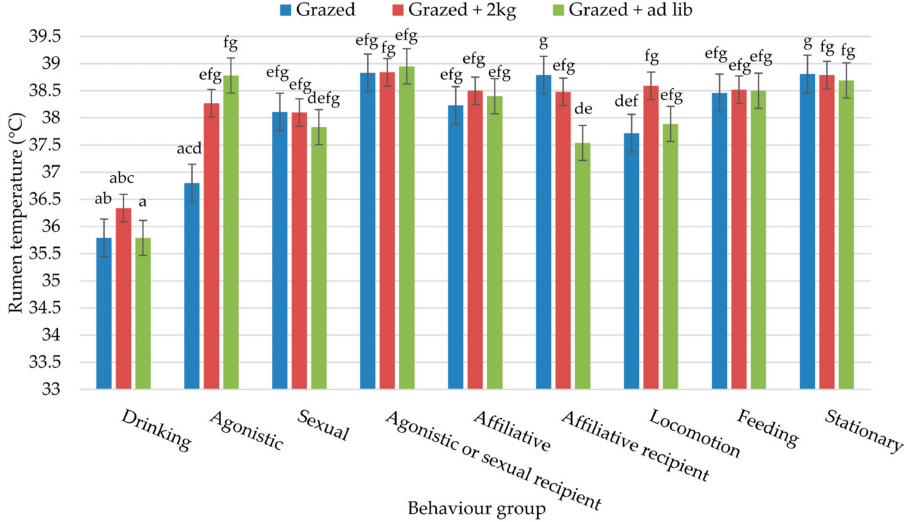
Figure 3. Interaction between behaviour and diet for bulls on Study 1: at grass; a–g represent significant di ff erences ( p = 0.047) between behaviour